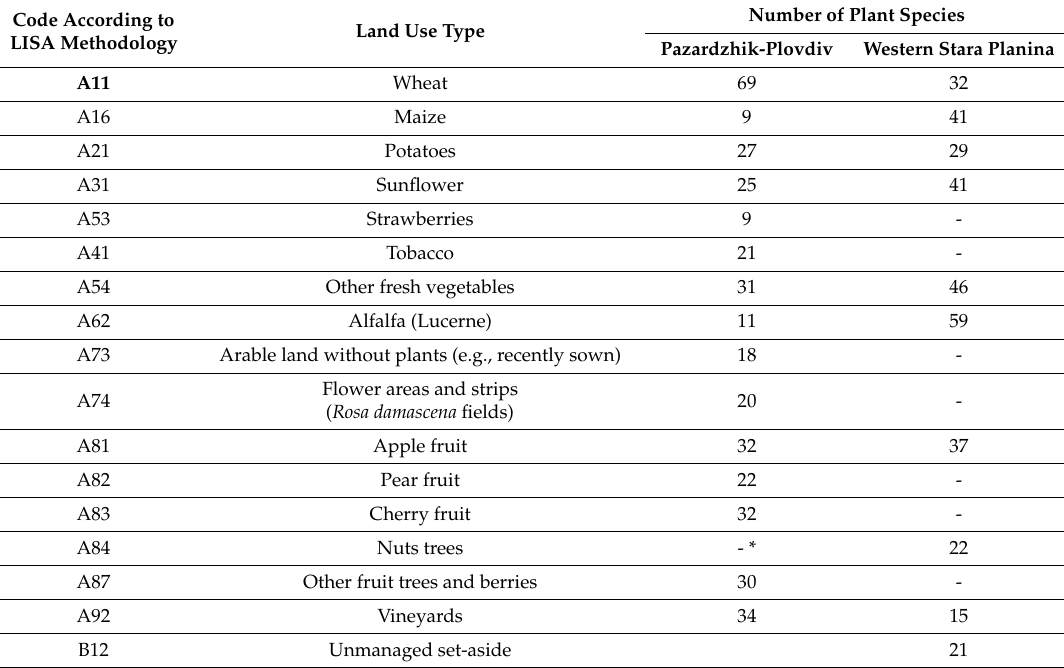
Table 4. Plant diversity by di ff erent land use types in the two regions of study. Code According to LISA